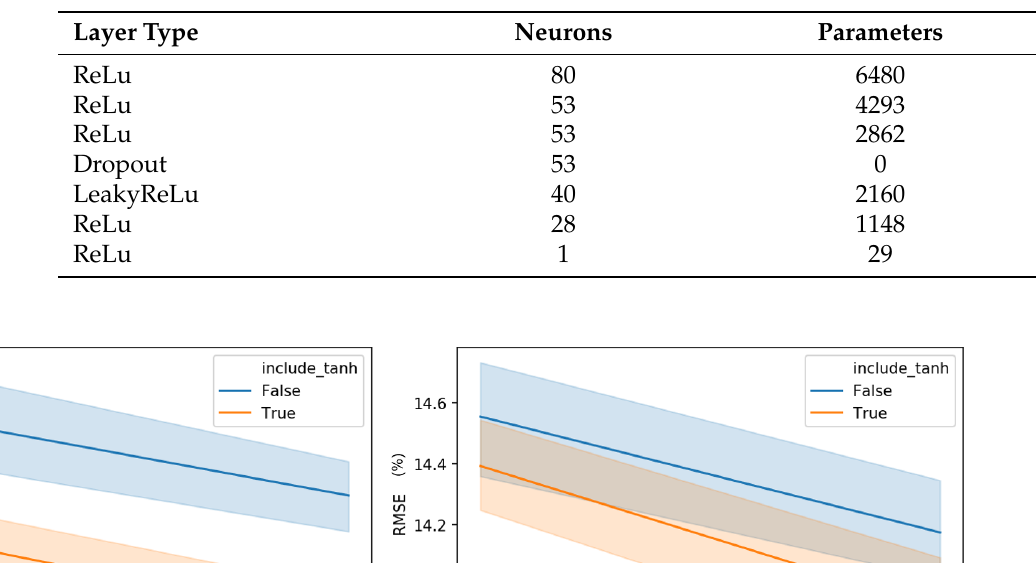
Table 2. This ANN is used to predict the wind speed and then a fitted power curve is used to predict power. The chosen architecture corresponds to look_back = 9 and no weighting scheme. The ANN has a total of 16.972 parameters. It takes the wind speed, wind direction, temperature and pressure as input variables.